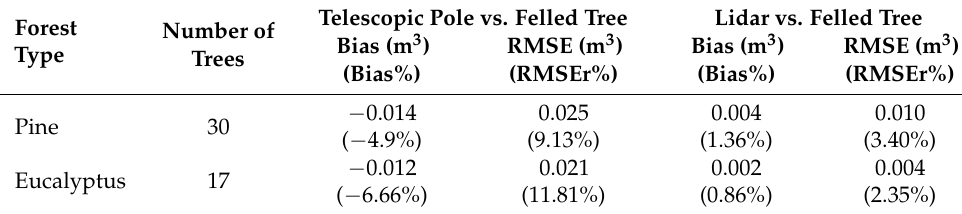
Table 7. Evaluation of single-tree volume results based on different tree height measurement methods.